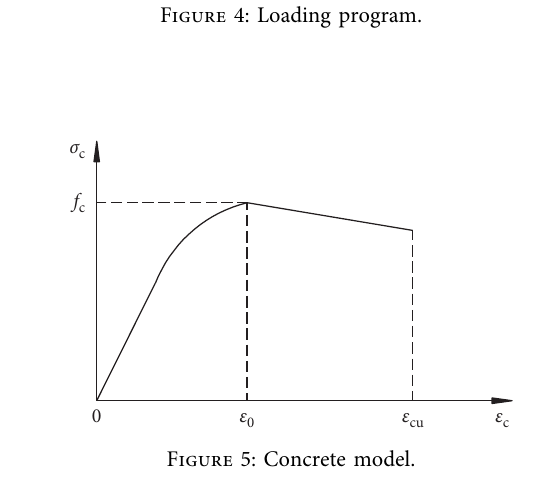
Figure 4: Loading program.